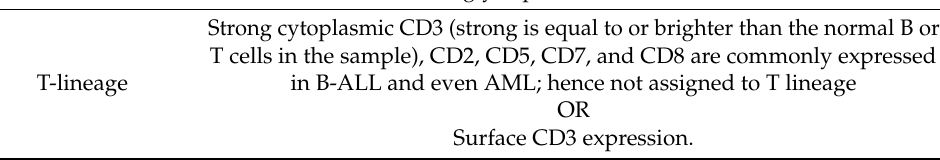
Table 2. Revised 4th edition World Health Organization (WHO) classification of acute leukemia of ambiguous lineage (ALAL). Myeloperoxidase (MPO) (Flow Cytometry, Immunohistochemistry or Cytochemistry) Myeloid Lineage OR Monocytic Differentiation (at Least 2 of the Following: Nonspecific Esterase Cytochemistry, CD11c, CD14, CD64, or Lysozyme) cytoplasmic CD22, or CD10